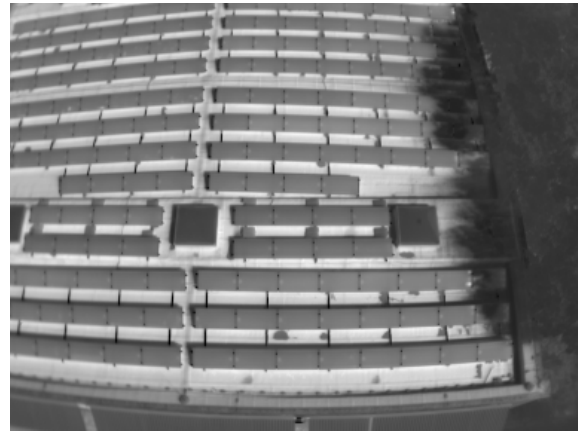
Table 4. Density of 3D point cloud, derived digital surface model (DSM), and resulting ortho image mosaic.